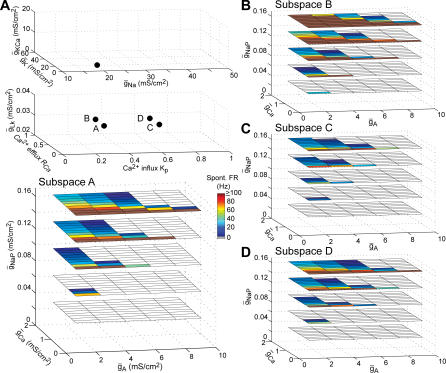
Systematic Search Across Conductance Space Revealed Continuous Variation in Baseline Spontaneous Firing RateThroughout the systematic search, values of
,
, and
([A], top graph) and
([A], middle graph, z-axis) remained fixed. In each subpanel, Kp and RCa are held fixed at four different values, labeled A, B, C, and D) ([A], middle graph). A systematic search of the lower 3-D subspace [
,
,
] for each of these points is shown graphically in A, B, C, and D, respectively. Each model in the [
,
,
] subspace is shown as a cell whose color represents its spontaneous firing rate, according to the colorscale on the right of subspace A. Uncolored cells were spontaneously silent models. Spontaneous firing rate depended sensitively on a balance between
and
: when
was high but
was low, rates were high, and vice versa. Firing rates also increased with RCa (from A to B and from C to D) and inversely with Kp (from A to C and from B to D).